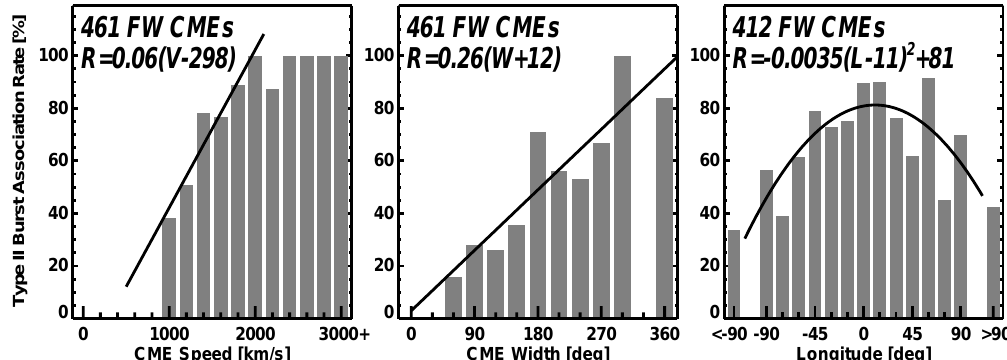
Fig. 4. Type II association rate of 461 FW CMEs as a function of CME speed (V, left), width (W, middle) and source longitude (L, right). The equations of the straight-line fits are shown on the plots. In the longitude plot, 49 completely backside events have been excluded. The speed and width bin sizes are as in Fig. 2. The longitude bins have a size of 15 ◦ ; each bin contains CMEs with longitudes within ± 7 ◦ .5 of the bin